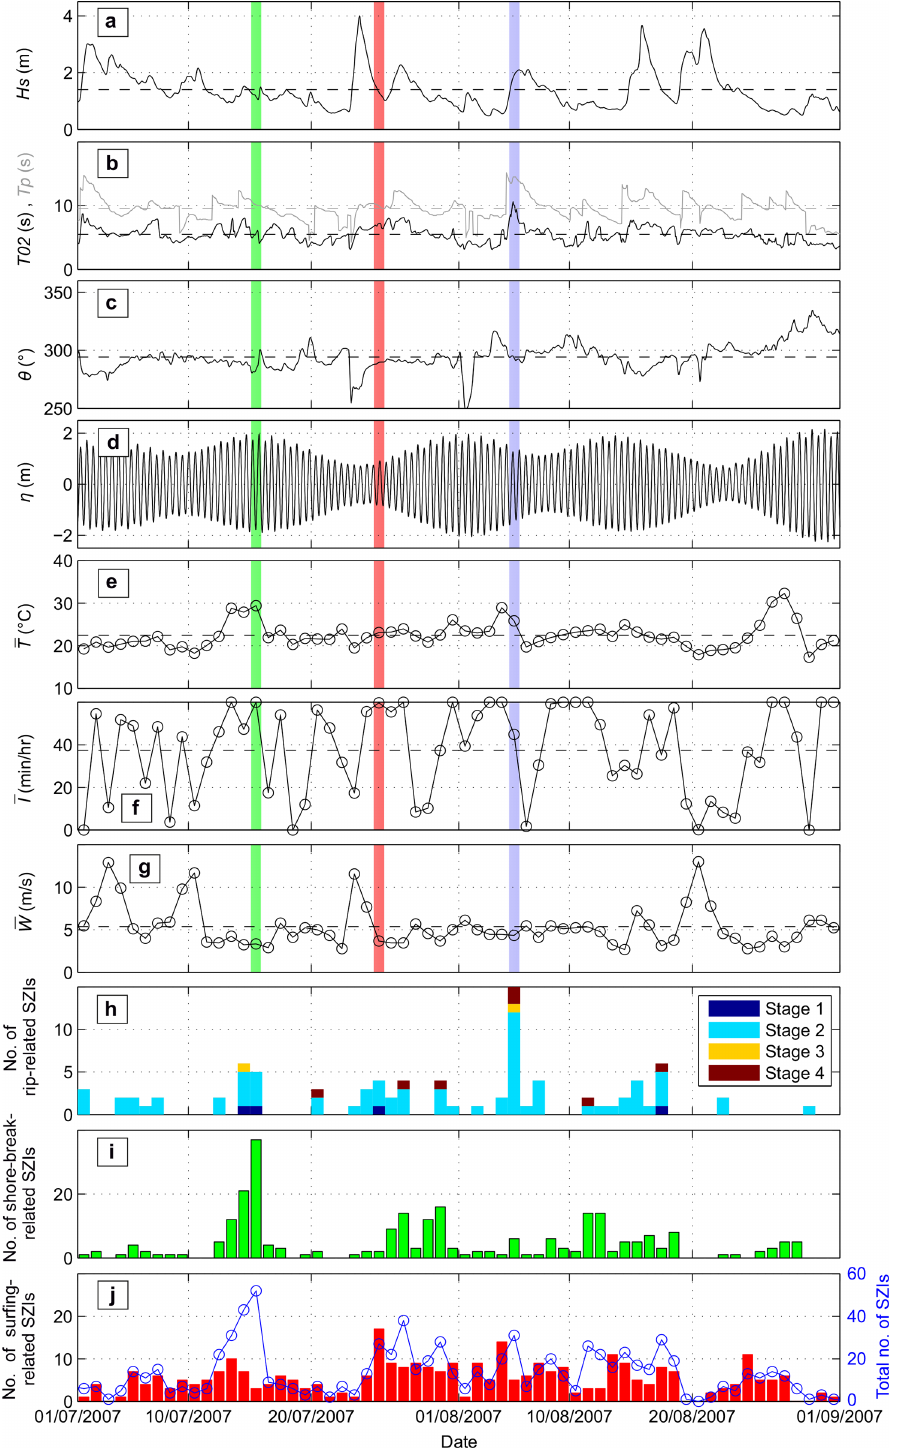
Figure 2. Time series during the 2007 summer of (a) significant wave height, Hs ; (b) peak and mean wave periods, Tp and T 02, respectively; (c) wave direction, θ ; (d) water level, η , with respect to mean sea level; (e) daily mean air temperature, T ; (f) daily mean hourly insolation, I ; (g) daily mean wind speed, W ; (h) distribution of rip-related SZIs; (i) distribution of shore-break-related SZIs; and (j) distribution of surfing-activity-related SZIs and total number of SZIs. In panels (a) – (g) the shaded green, red and blue vertical areas indicate the days with the largest number of shore-break-, surfing- and rip-related SZIs during the 2007 summer. In panels (a) , (b) , (c) , (e) , (f) the summer mean is indicated by the horizontal dashed